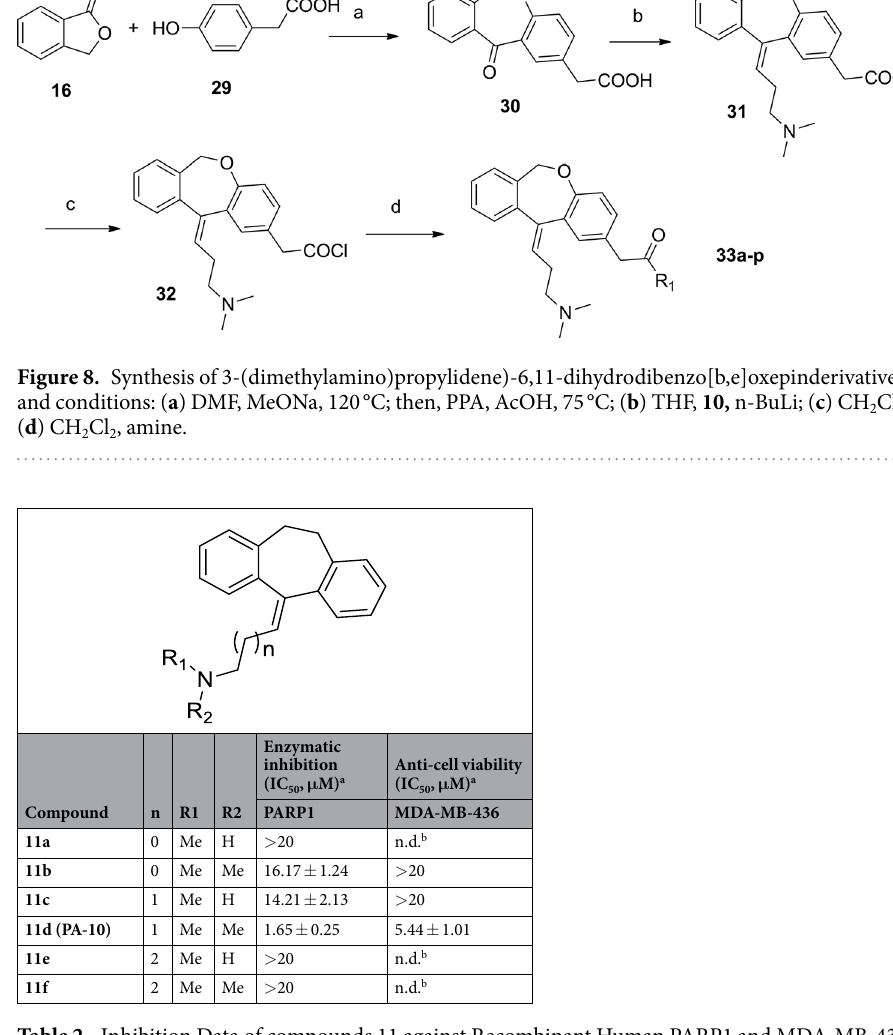
Table 2. Inhibition Data of compounds 11 against Recombinant Human PARP1 and MDA-MB-436 cells. a The IC 50 values are presented as mean ± SD, which is determined by at least three independent experiments. b The n.d. means data are not determined.